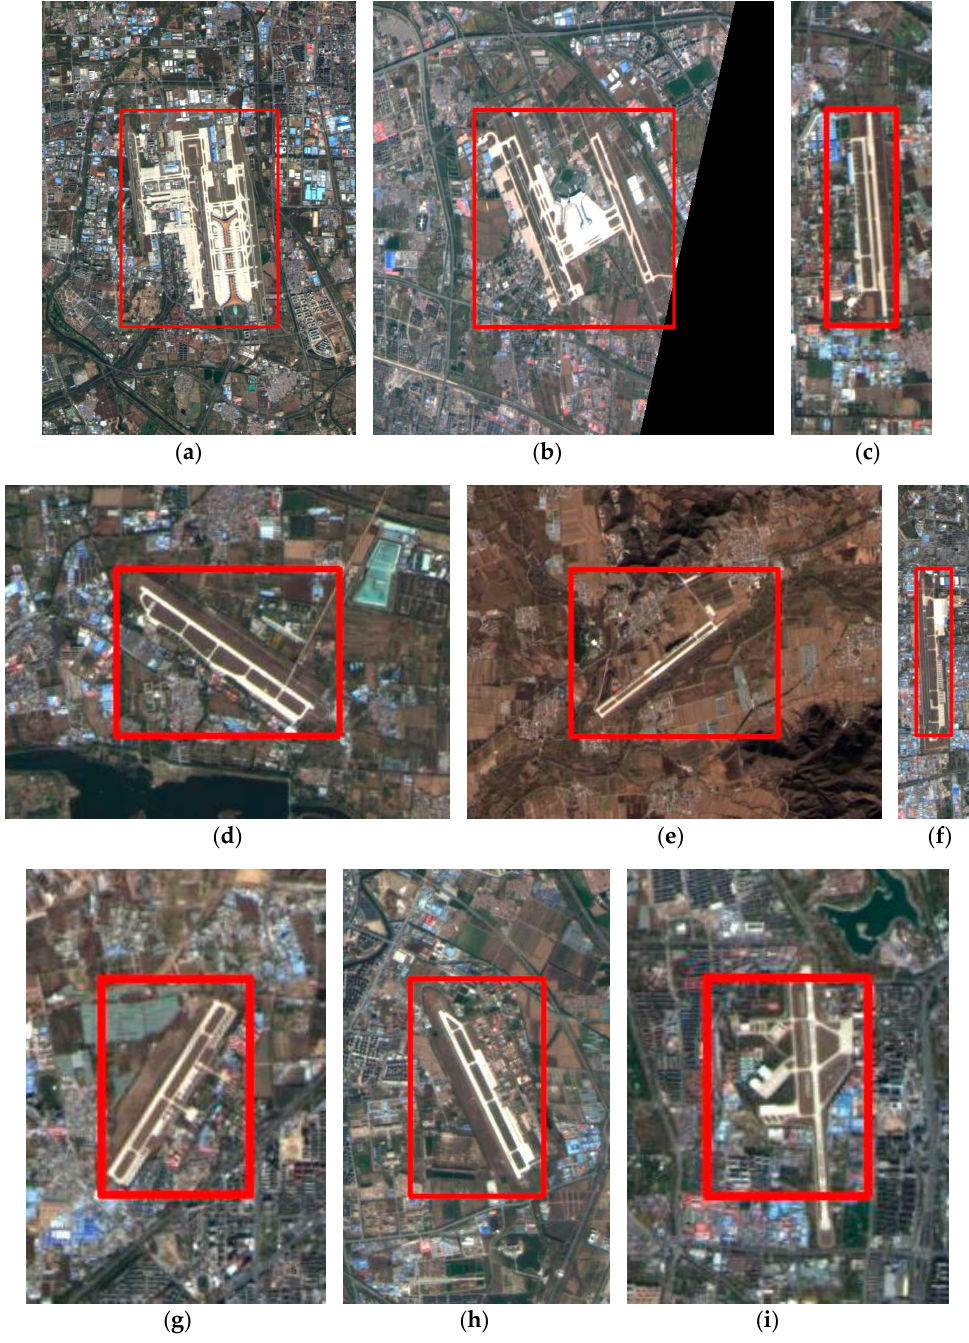
Figure 18. Detection results in the Gaofen-1 satellite scene by the proposed method. ( a )–( i ) Nine true detection results. All images have been zoomed to the same image height for a clear presentation.